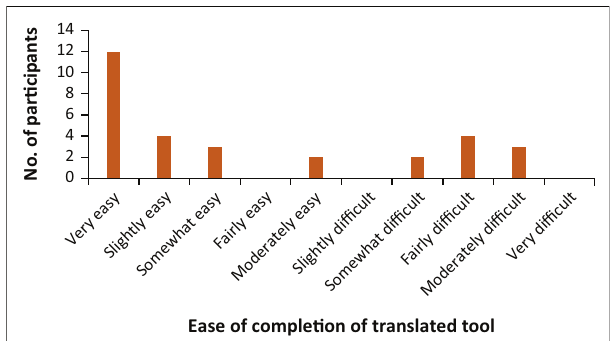
FIGURE 2: Ease of completion of the translated tool ( n = 30).